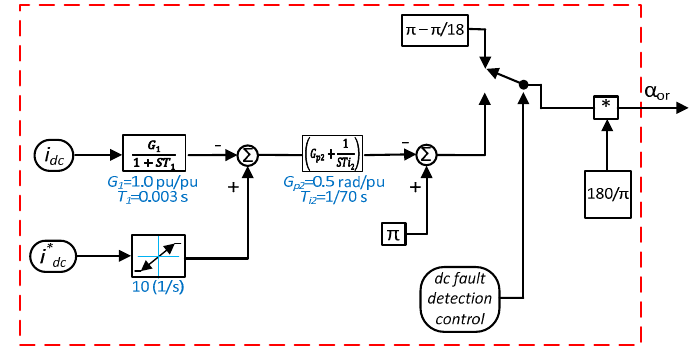
Figure 4. Rectifier DC current control block diagram.